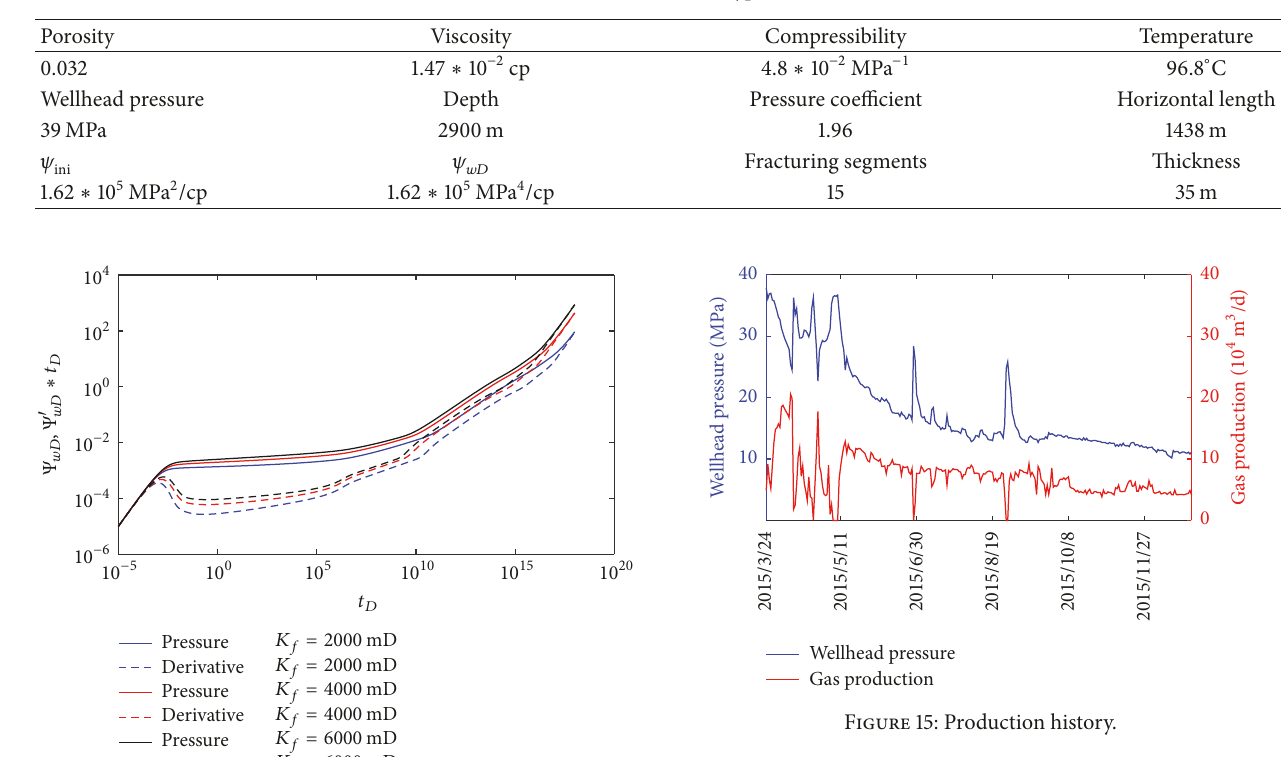
the induced fracture permeability also affects the scale of production rate; that is, the higher the permeability, the larger the scale. However, as far as production rate is concerned, the secondary fracture permeability only affects its scale, but not its decline rate.